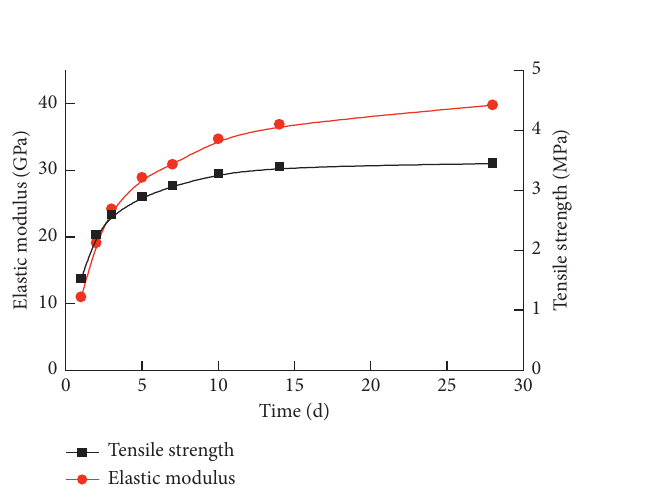
Figure 12: The mechanics parameters of box girder concrete.